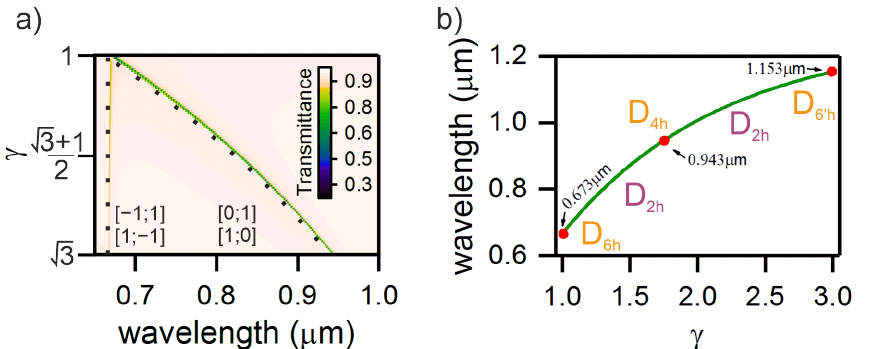
Figure 3. ( a ) Transmittance spectra of the two-dimensional structure with increasing γ = p / p x . Closed circles show the positions of the resonance line calculated using Equation (10). ( b ) Dynamics of the resonance line wavelength during the transition of the D 2h -symmetric structure between the high-symmetric points D 6h , D 4h , and D 6’h .